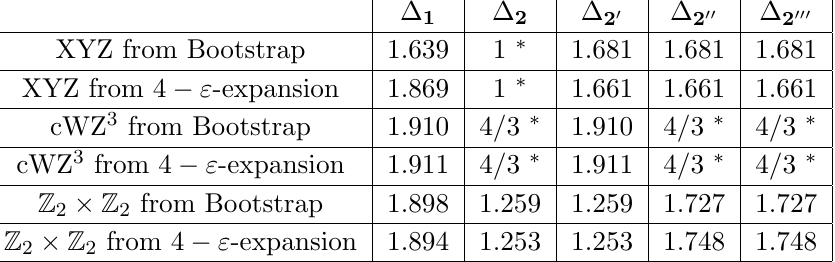
Table 2 . Summary of results for the doublet and singlet scaling dimensions that are not (cid:12)xed by symmetry in 3d for the XYZ, cWZ 3 , and Z 2 (cid:2) Z 2 theories at (cid:28) = 0 ; 1 ; (1 (cid:0) from the numerical bootstrap and the resummed 3-loop 4 (cid:0) " -expansion. The results marked with a (cid:3) are